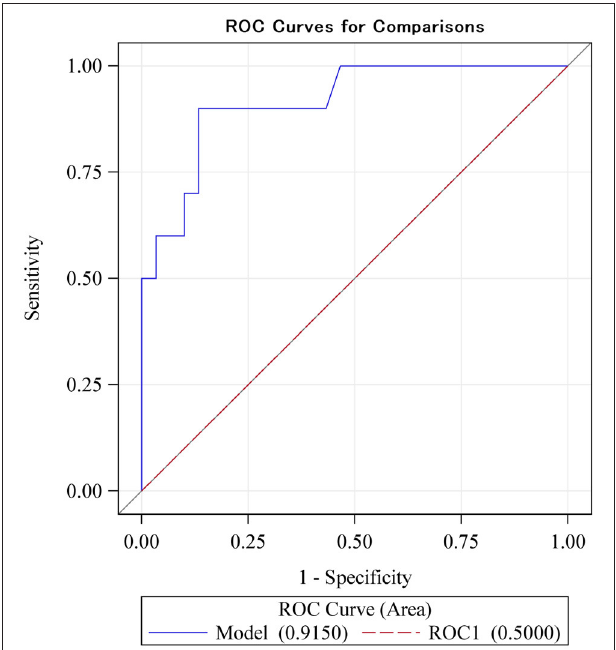
FIGURE 3 | The ROC sensitivity curve of the main explanatory variable (difference between monomodal and bimodal gamma steady-state response) as a predictor of low intelligence scores (defined as lower than two-thirds of a standard deviation below the mean). With a cut-off value for 1 C A of 0.25 the sensitivity for prediction of low memory is as high as 0.9 and the specificity is as high as 0.87 (Youden-index: 0.77). The ROC sensitivity is 92% (CI: